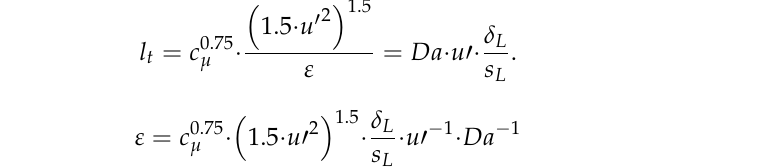
(cid:2) (cid:3) m 2 /s 3 values used for imposed u (cid:48) and Da levels.